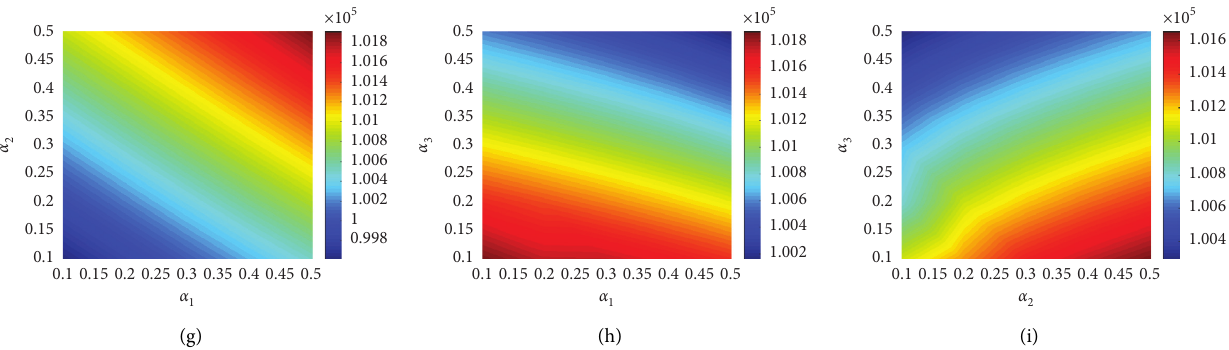
Figure 11: Parameters α (g–i) α